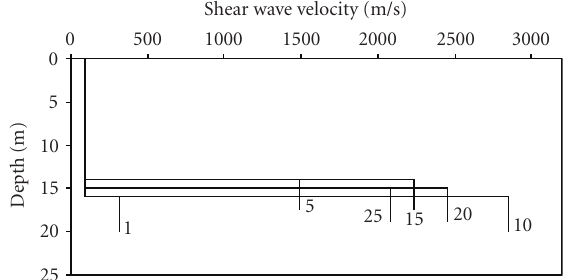
Figure 4: Layer models of depth-shear wave velocity for NRC site. Shear wave velocity profiles for di ff erent contrast ratios of the initial model, shown at the end of each profile. In the initial models, bedrock depth and average soil velocity values are fixed.